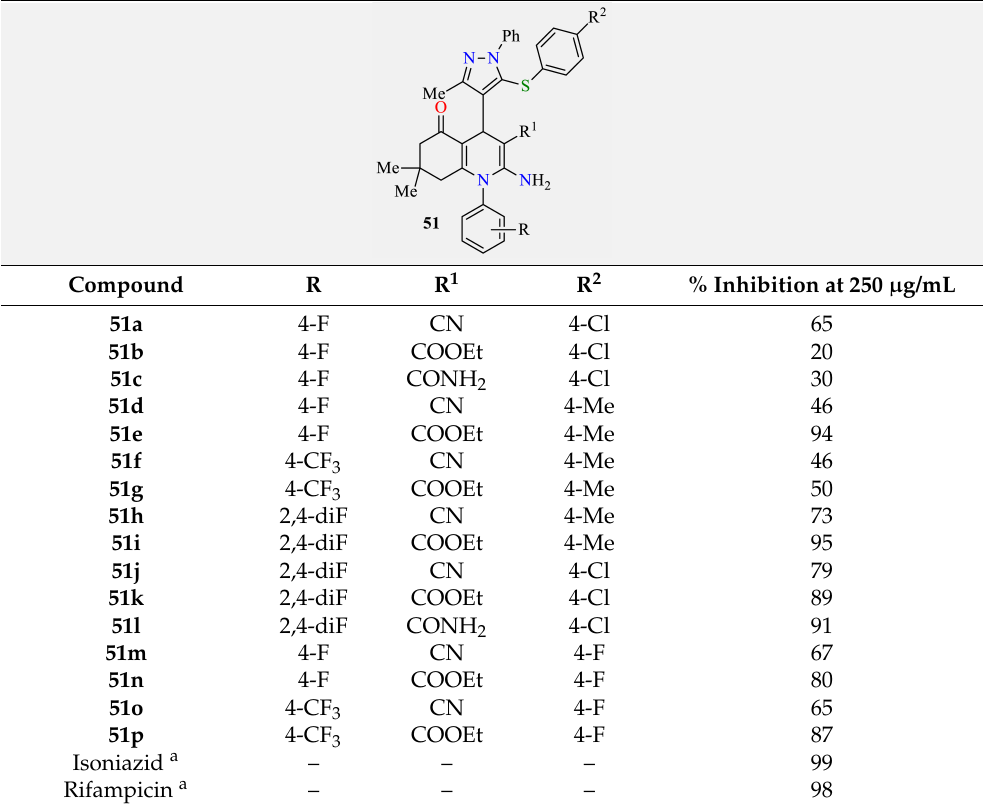
Table 50. Antituberculosis activity of polyhydroquinoline derivatives 51